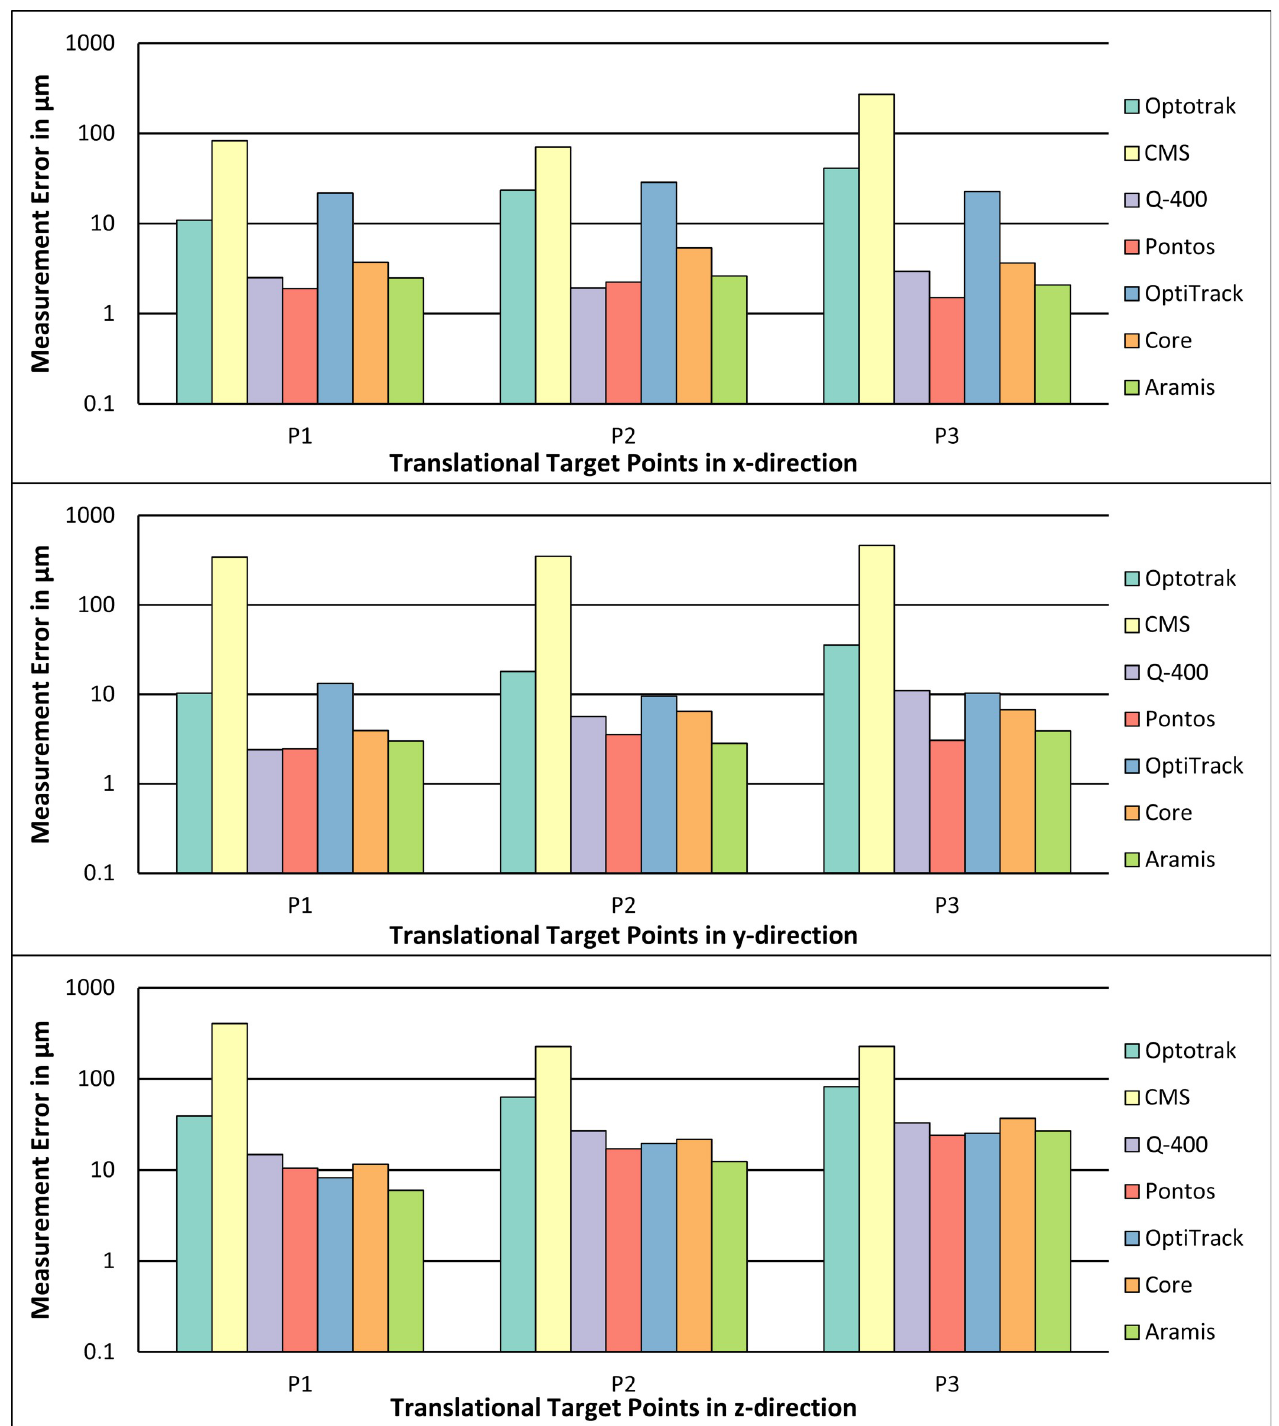
Fig 6. Measurement errors of the accuracy measurements of the translational motions in x-direction (top diagram), y-direction (middle diagram) and z- direction (bottom diagram) for the seven measurement systems using the manual reference device.